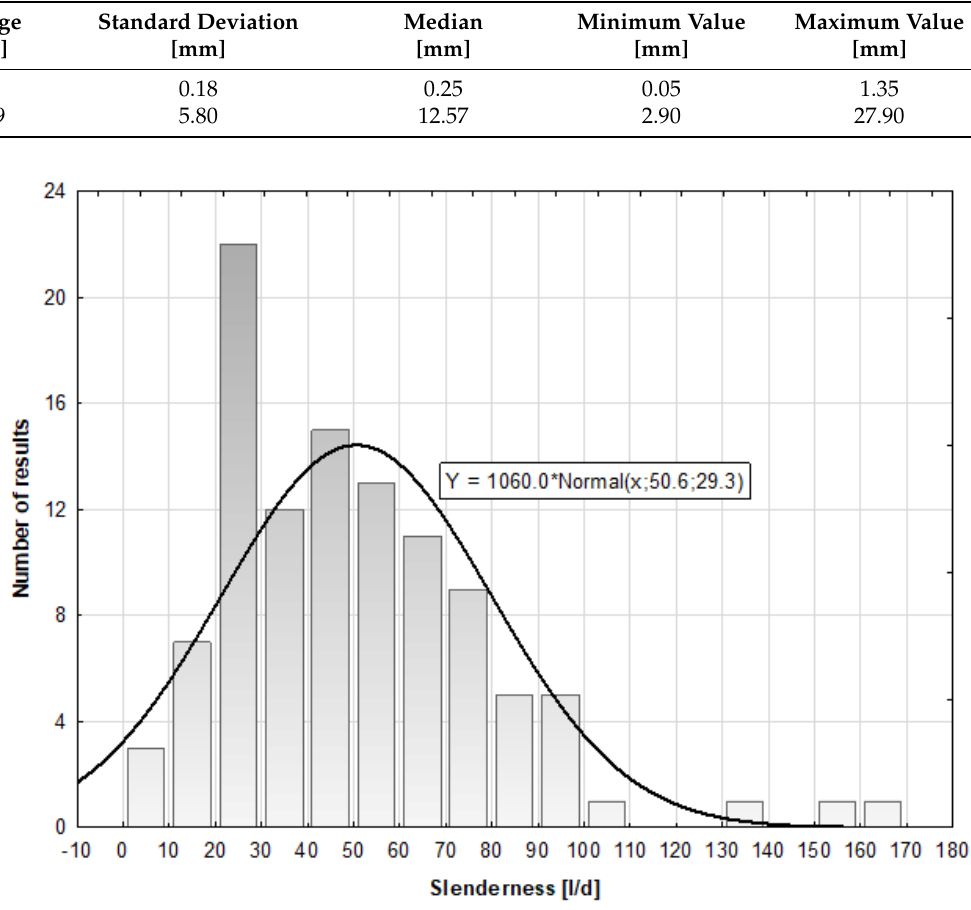
Table 1. Parameters of steel cord.